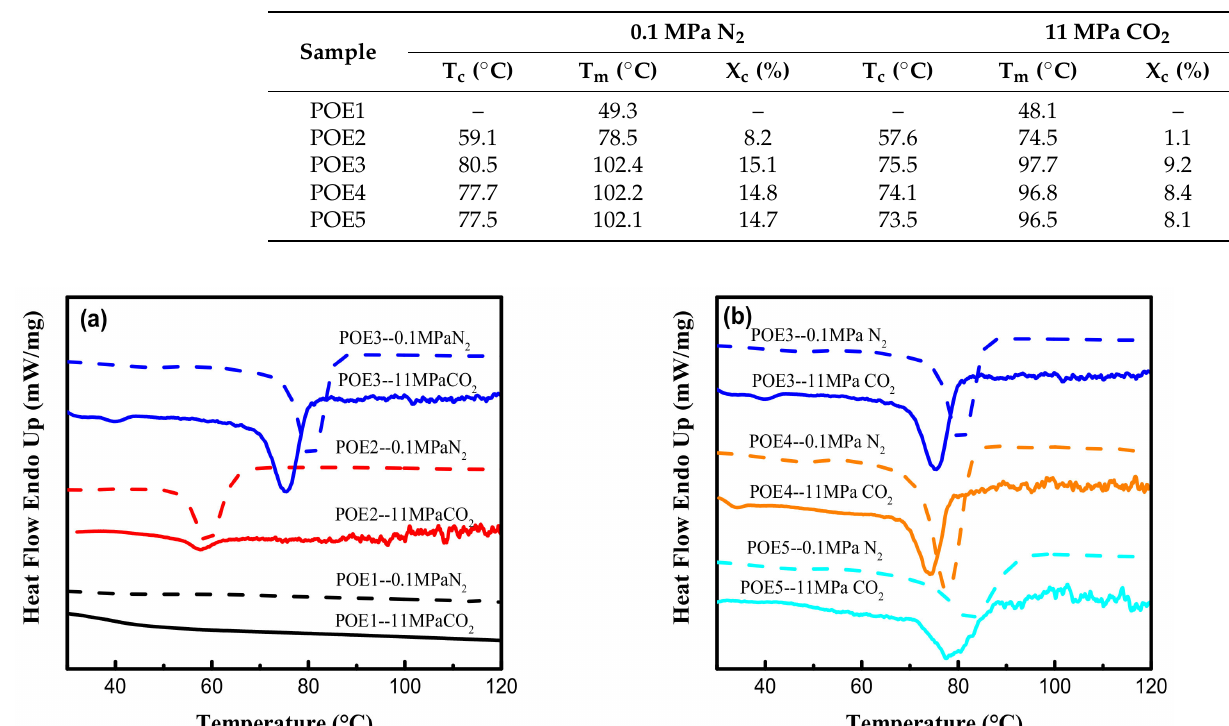
Figure 3. DSC curves of POE samples at a cooling rate of 10 ◦ C/min. ( a ) POE samples with same MI; ( b ) POE samples with same octene content.